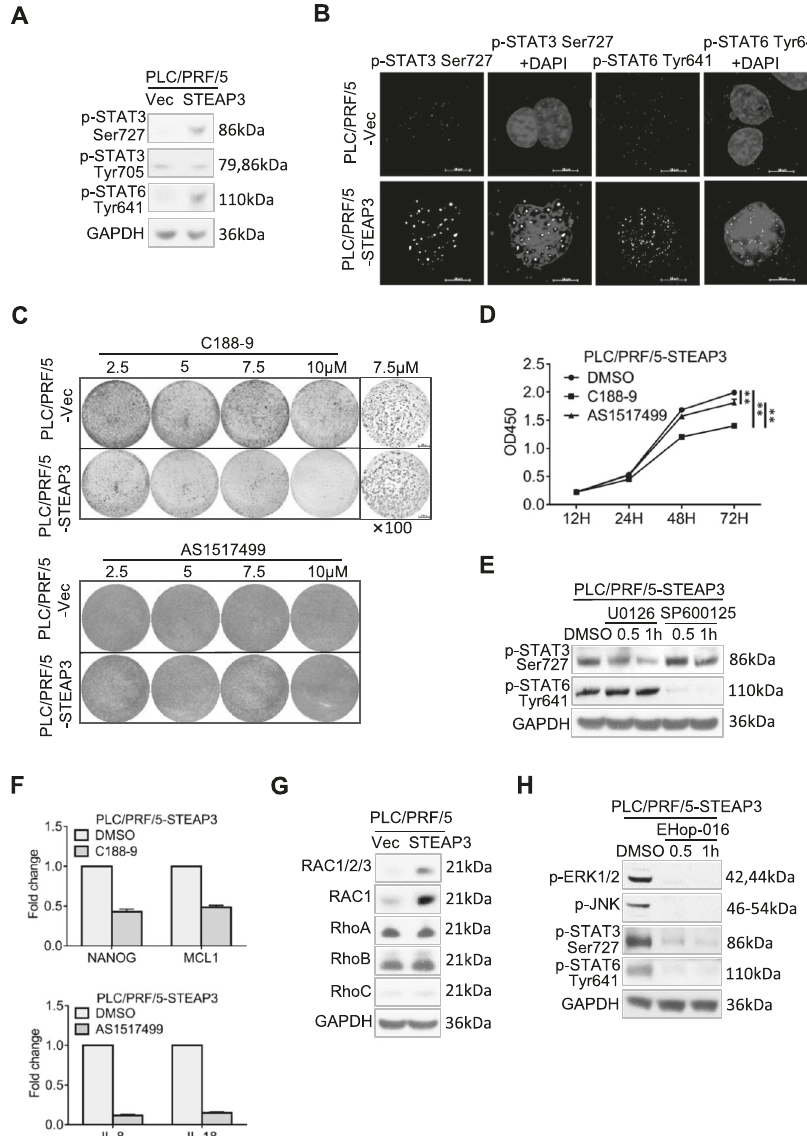
Fig. 4 STEAP3 regulates RAC1 to activate ERK-STAT3/JNK-STAT6 signaling axes to promote cell proliferation in HCC. A Phosphorylation levels of STAT3 and STAT6 were examined by western blot. B Nuclear translocation of p-STAT3 Ser727 and p-STAT6 Tyr641 was veri fi ed by IF in PLC/ PRF/5-STEAP3 and control cells. Nuclei were visualized by DAPI (blue). Scale bar, 10 μ m. C PLC/PRF/5-STEAP3 and control cells were starved for 24 h, then supplemented with serum and administrated with different doses (2.5, 5, 7.5, 10 μ M) of STAT3 and STAT6 inhibitor, C188-9 and AS1517499, respectively, for 2 h. Scale bar, 200 μ m. Cells were fi xed, and visualized by crystal violet. D Cell viability was examined by CCK8 assays in PLC/PRF/5-STEAP3 treated with C188-9 (0.5 μ M) and AS1517499 (1 μ M), respectively. Cells administrated with DMSO were used as a control. Data are presented as means ± SD of three independent experiments. ** p < 0.01. E Phosphorylation levels of STAT3 Ser727 and STAT6 Tyr641 were examined by western blot after U0126 and SP600125 administration for 0.5 and 1 h, respectively, in PLC/PRF/5-STEAP3. F mRNA levels of NANOG, MCL1, IL-8 and IL-18, were examined by real-time RT-PCR in PLC/PRF/5-STEAP3 after administration with C188-9 and AS1517499, respectively, and presented as means± S.D. of three independent experiments. G Expression levels of Rho GTPase family members (RAC1/2/3, RAC1, RhoA, RhoB, and RhoC) were examined by western blot in PLC/PRF/5-STEAP3 and control cells. H Phosphorylation levels of ERK1/2, JNK, STAT3 Ser727, and STAT6 Tyr641 were examined by western blot in PLC/PRF/5-STEAP3 after RAC1 inhibition by EHop-016 (5 μ M) for 0.5 and 1